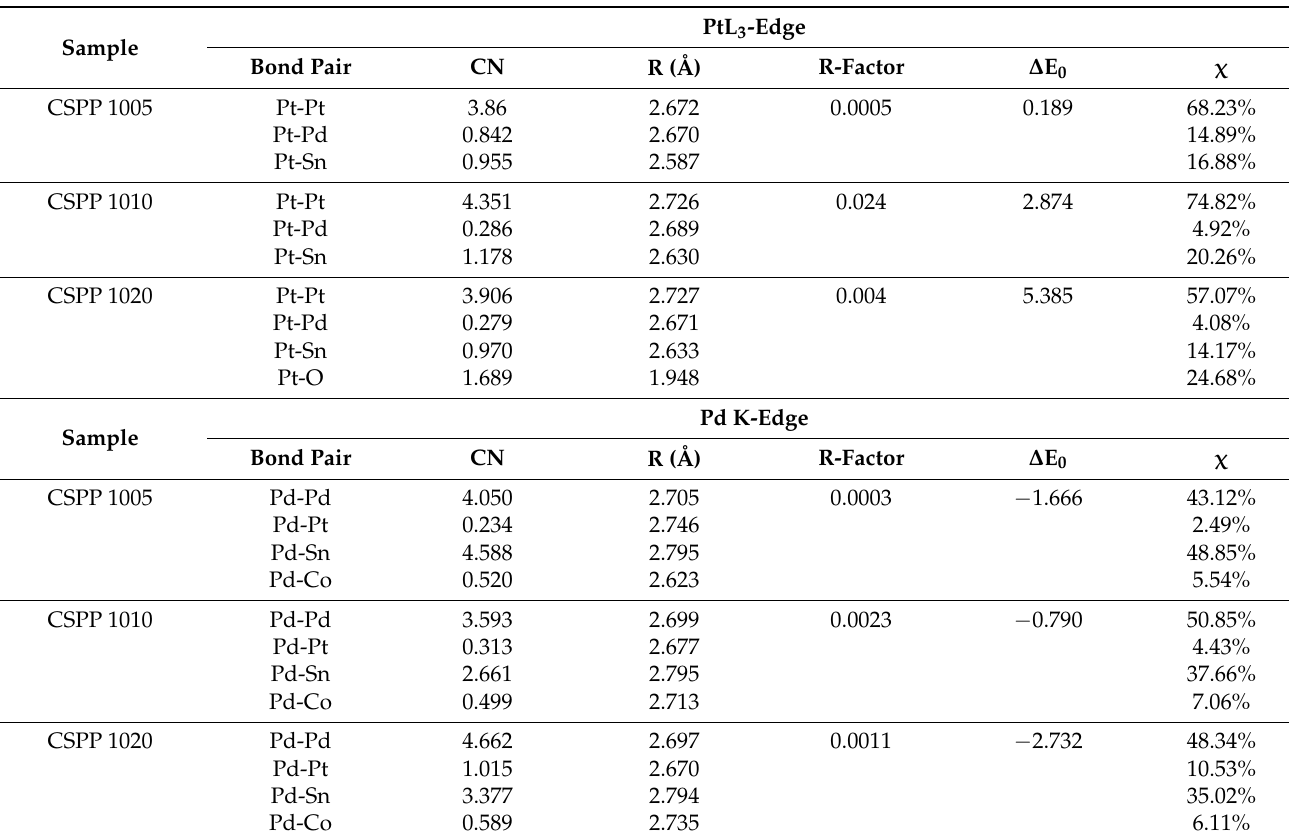
Table 1. Quantitative results of X-ray absorption spectroscopy model analysis at the Pt L 3 -edge and Pd K-edge of experimental